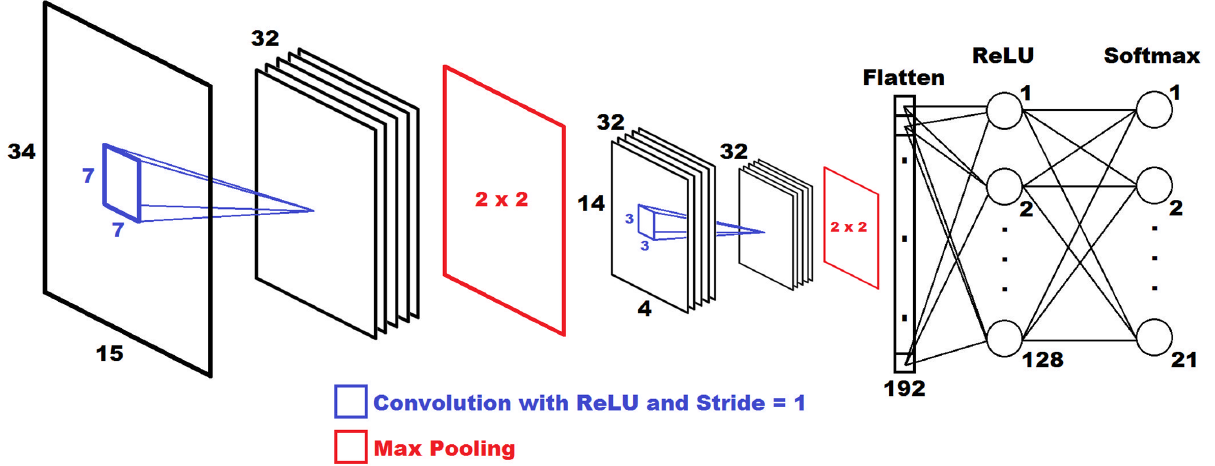
Fig 3. Convolutional neural network architecture. The structure of the convolutional neural network is displayed. Initially, two convolution and max pooling layers are used. Then, the feature maps are flattened and input into a fully connected network. Finally, a layer with the softmax activation function is used to obtain the